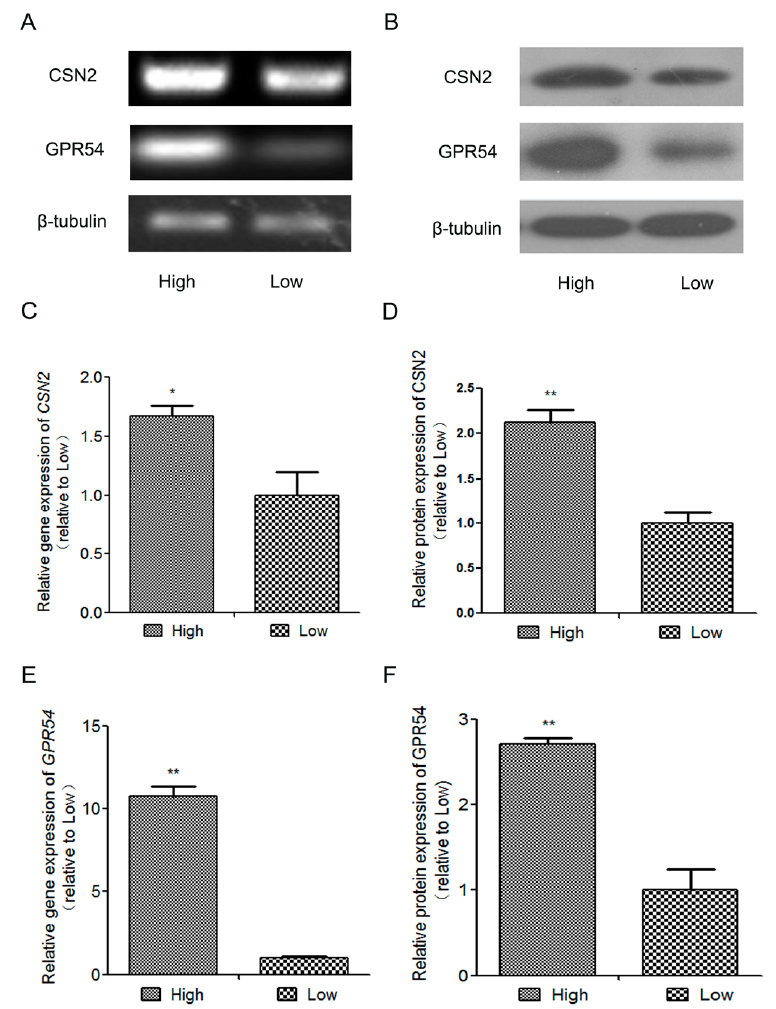
Figure 1. The gene and protein expressions of β -casein ( CSN2 ) and GPR54 in high-quality milk (High) and low-quality milk (Low) mammary gland tissues from lactating Holstein dairy cows. ( A , C , E ) The gene expressions of GPR54 and CSN2 were detected by PCR. ( B , D , F ) The protein expressions of GPR54 and CSN2 were detected by Western blot. The relative mRNA level was normalized to β -tubulin mRNA, and the relative protein levels were quantified by scanning densitometry and normalized to β -tubulin. The data are presented as the means ± S.D. ( n = 5 per treatment; * p < 0.05, ** p < 0.01 vs. low-quality milk mammary gland tissues).